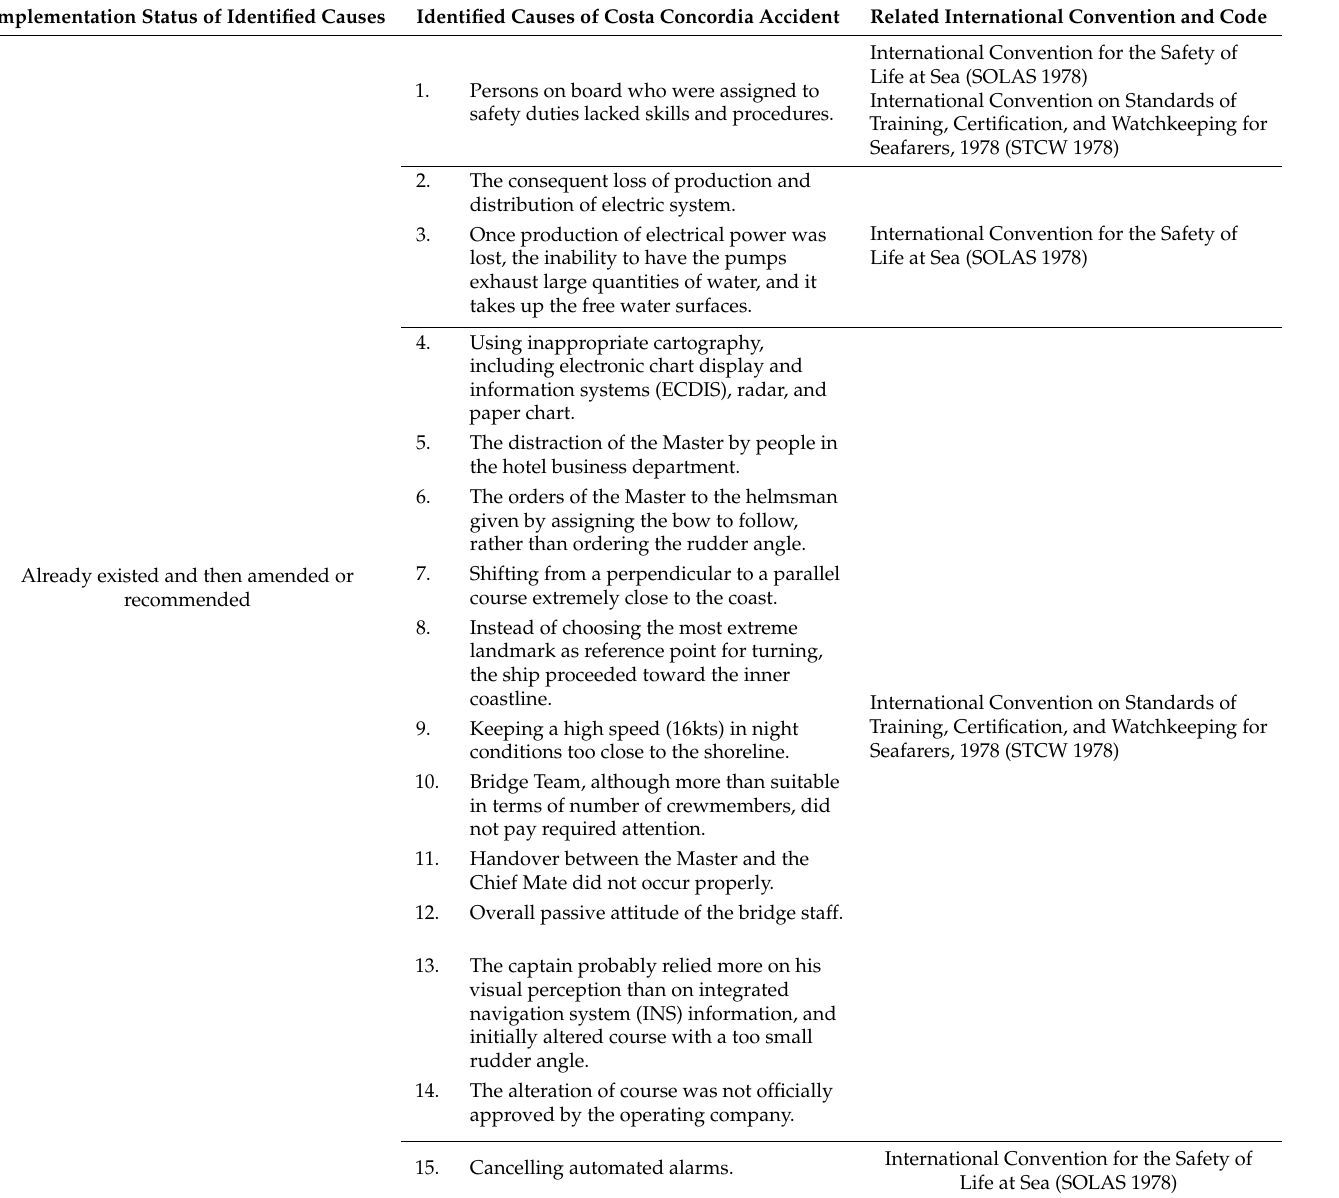
Table 1. Causes of the Costa Concordia accident and their implementation